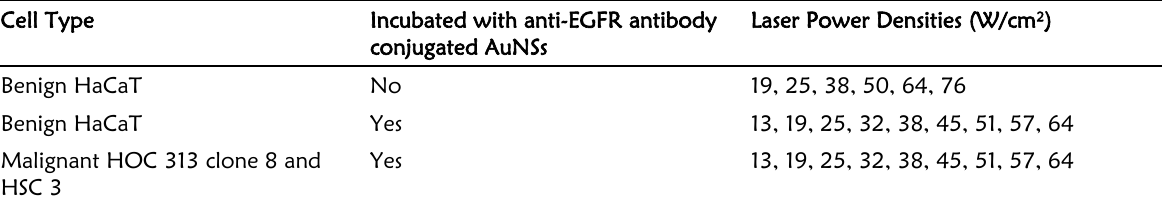
Table 1: Laser Power Densities per Cell Culture Sample [35]